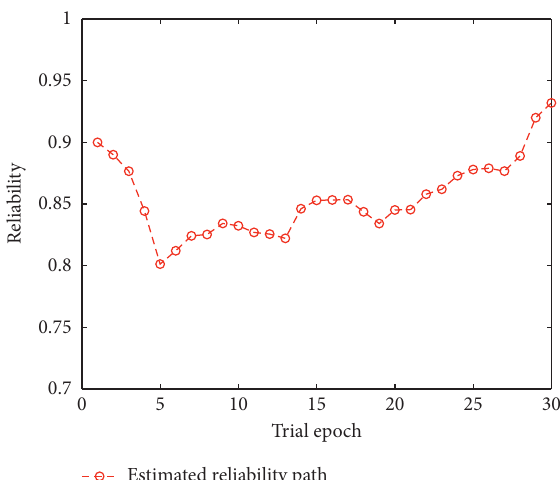
Figure 5: Estimated reliability path throughout the trial.